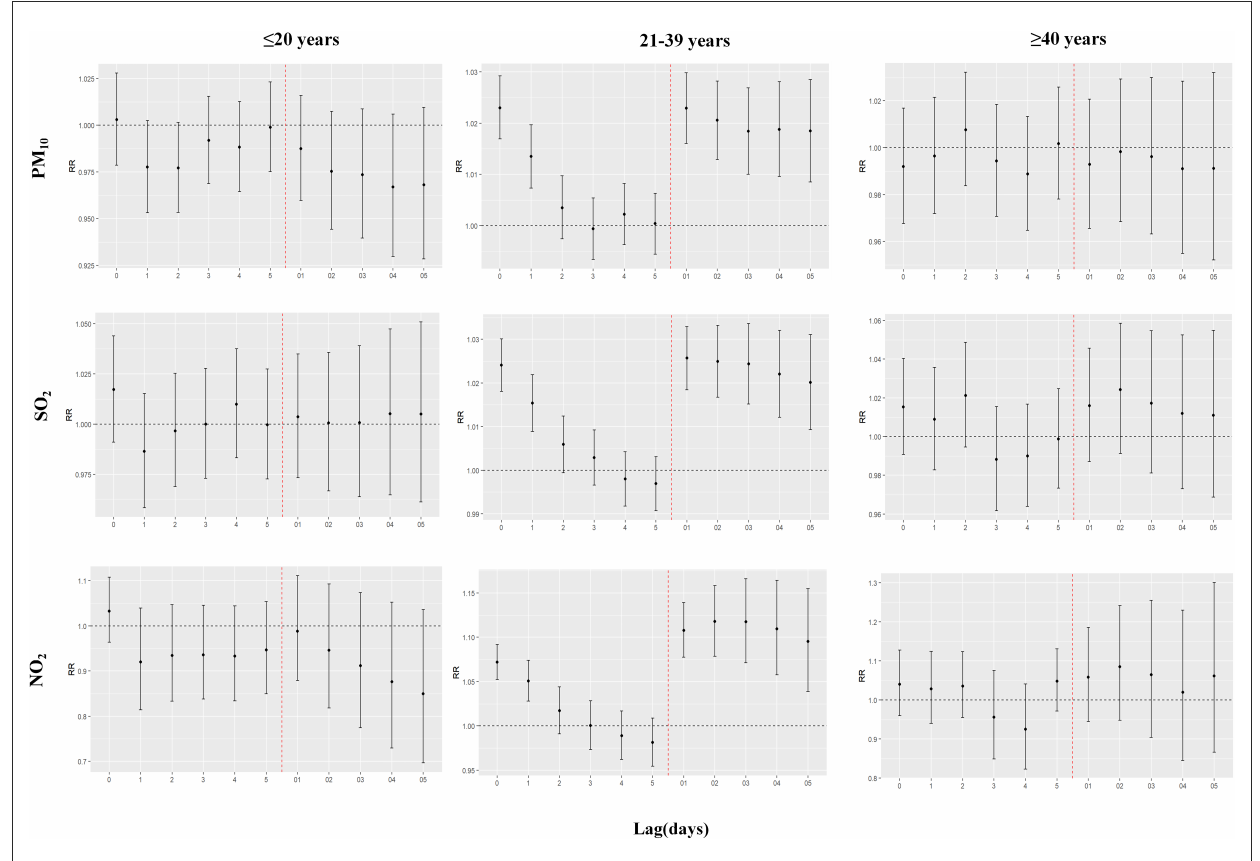
FIGURE3 Age-specific analysis of appendicitis admissions per 10 µ g/m 3 increase in pollutant